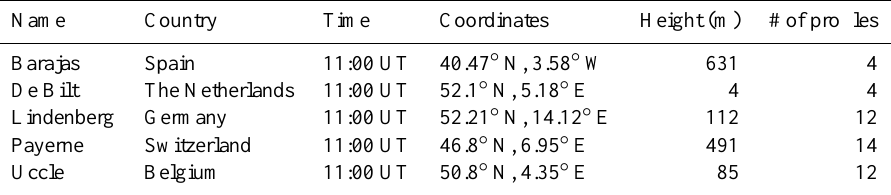
Fig. 9. Comparison between monthly mean ozone vertical profiles (surface to 12km) for the four quadrants of the domain. The profiles were drawn from two distinctive runs: one with assimilation, called EnSRF (red curve) and the other one, free run “without assimilation” called Ref (blue curve); the averages were calculated first over the corresponding grid cells and then over the month. The error bars correspond to the monthly standard deviation of the vertical profiles. The unit measure for the vertical profiles is ppb.